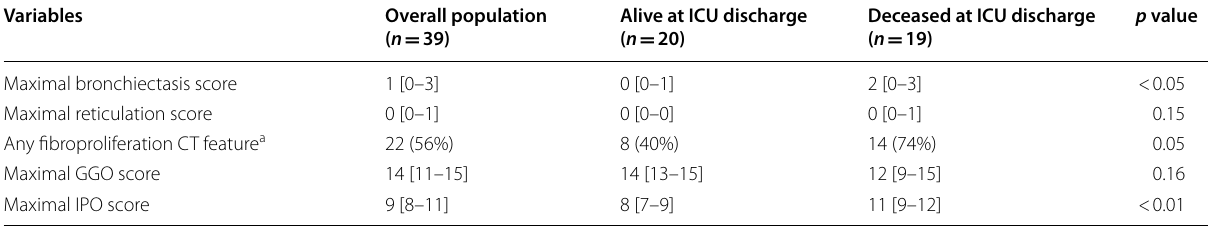
Values are median [1st quartile-3rd quartile] or count (percentage) CT computed tomography, GGO ground glass opacification, ICU intensive care unit, IPO intense parenchymal opacification a Any fibroproliferation CT feature was defined as occurrence of at least one bronchiectasis score or reticulation score > 0 during ICU